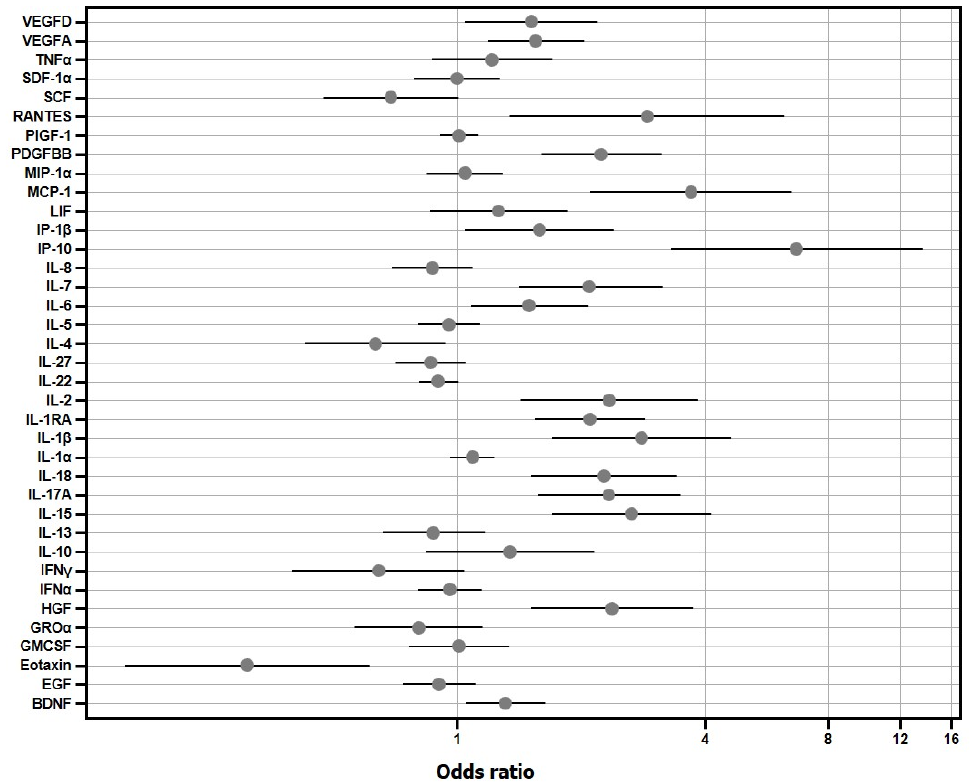
Figure 1. Individual logistic regression models showing odds ratio and 95% confidence interval for each cytokine. Note the logarithmic x-axis.